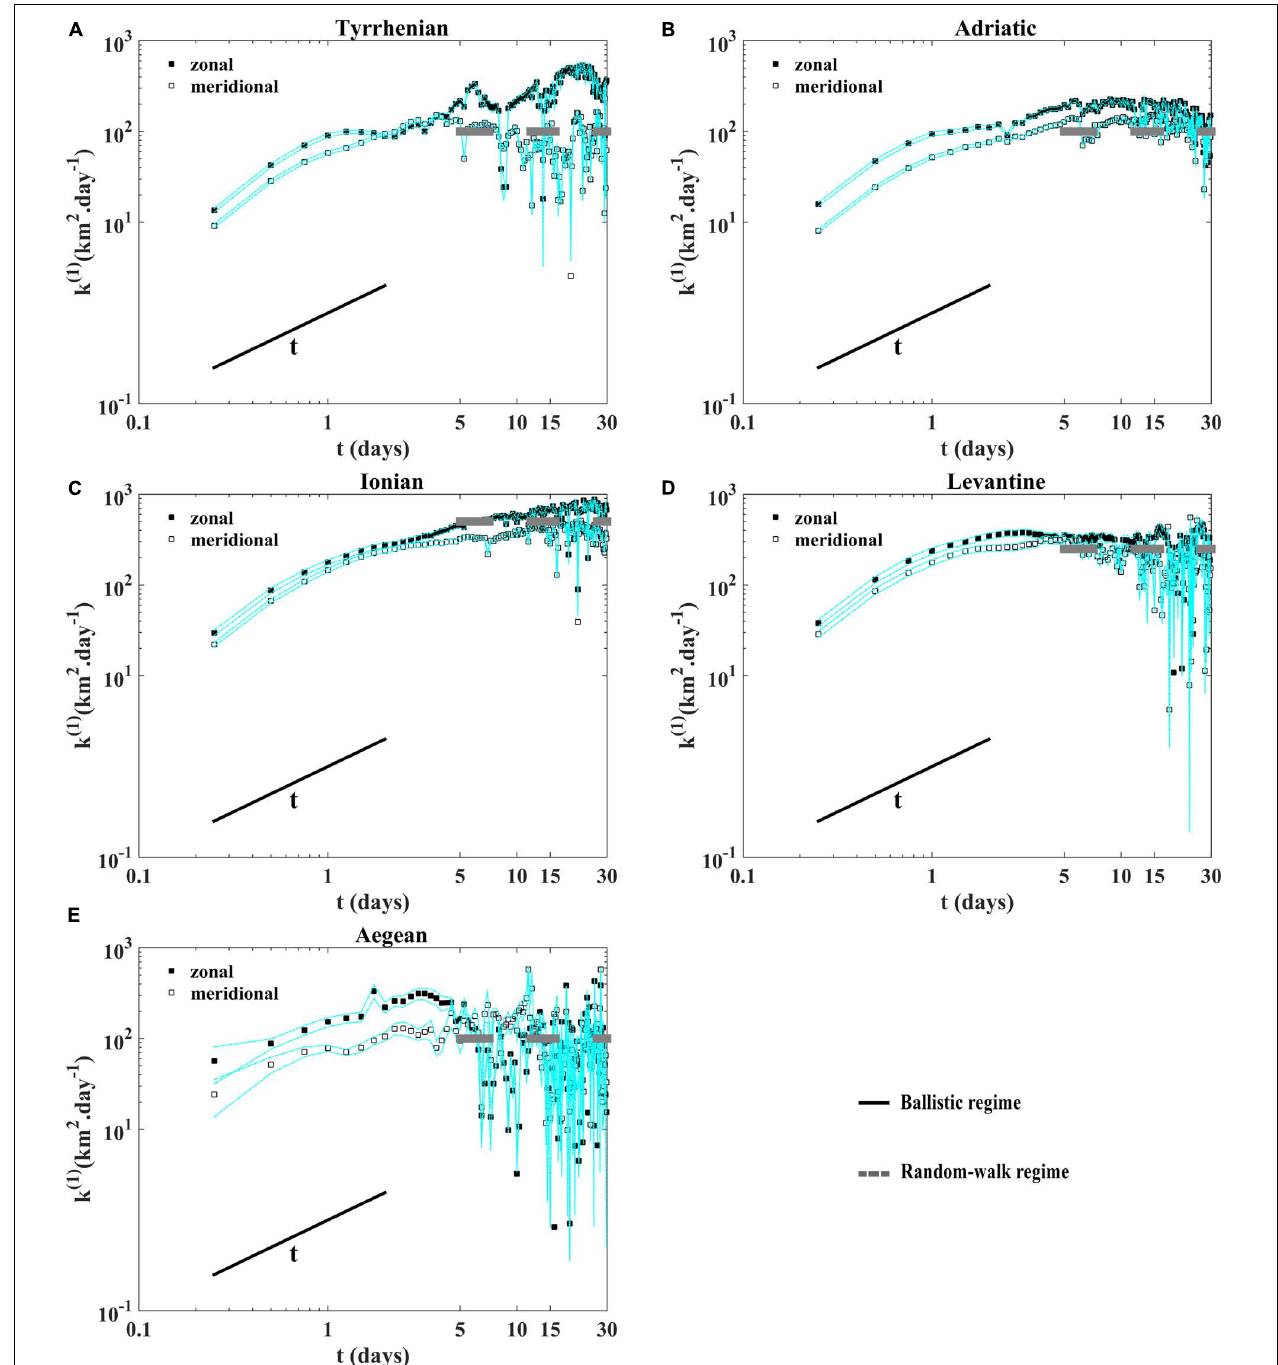
FIGURE 6 | Absolute diffusivity for the zonal and meridional components as a function of time in loglog plot (A) in the Tyrrhenian, (B) the Adriatic, (C) the Ionian, (D) the Levantine, and (E) the Aegean sub-basins. The diffusive random-walk is shown with the thin black line and the horizontal dashed gray lines show the constant absolute diffusivity values. The dashed cyan lines indicate the 90% confidence intervals from bootstrap resampling, give a rough idea of the uncertainties for the statistics.